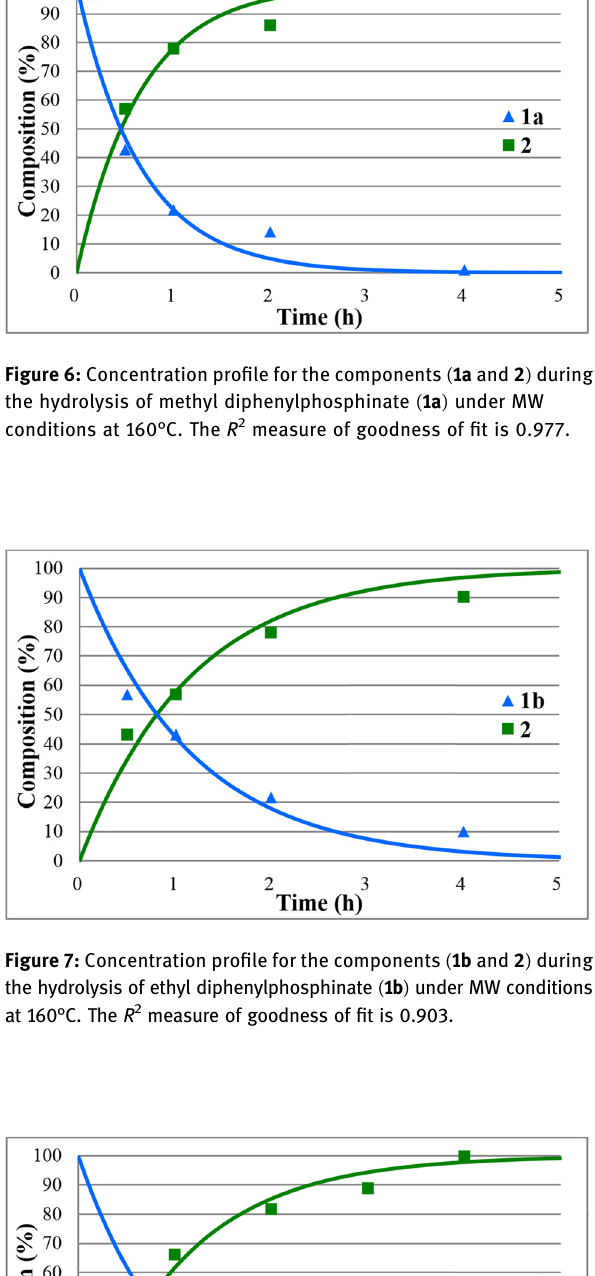
Table 4: Alkaline hydrolysis of alkyl diphenylphosphinates ( 1a – b